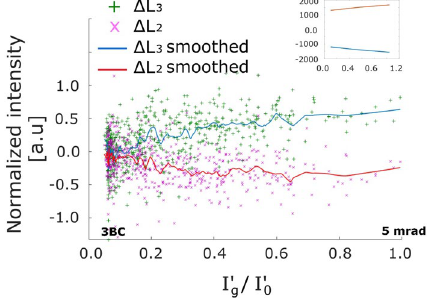
′ ′ / I 0 values. The g